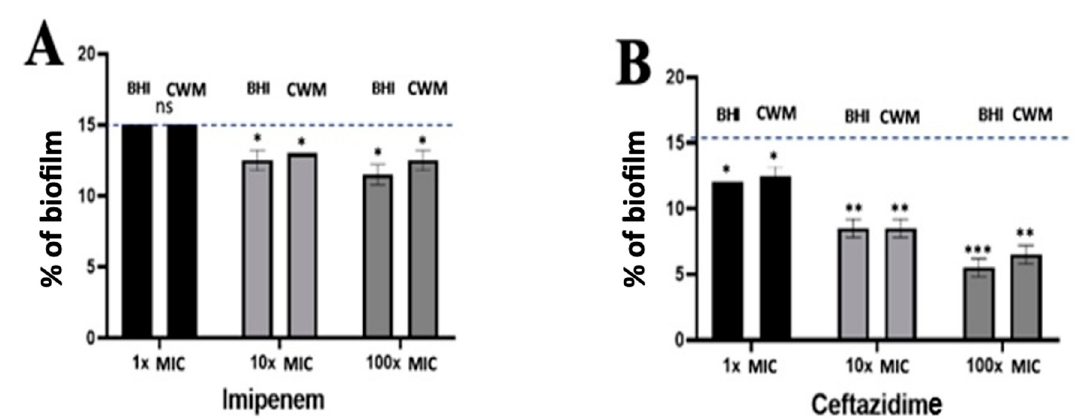
Figure 7. Percentage of biofilm reduction on preformed Pseudomonas aeruginosa PAO1 biofilm in the BioFlux TM system using imipenem ( A ), and ceftazidime ( B ) at different concentrations (1x, 10x and 100x MIC) and in the CWM and BHI media. An automatized debridement was fixed at 15% of biofilm left in the microfluidic channel. Samples were tested in three independent experiments. Results are presented as the mean ± standard deviation. Statistics were performed using a t-test on GraphPad Prism version 7. Ns, p > 0.05; * p < 0.1; ** p < 0.01; *** p < 0.001. Antibiotics efficiency on preformed Pseudomonas aeruginosa PAO1 biofilm.